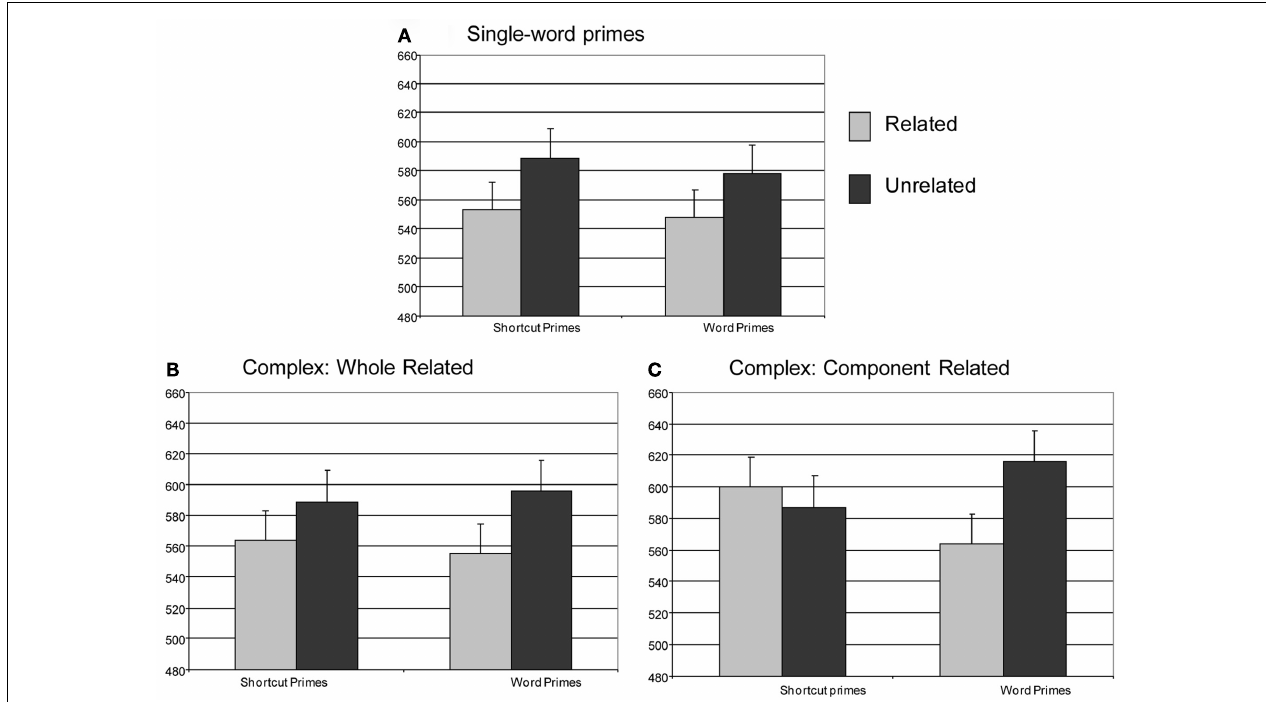
FIGURE 2 | Results of Experiment 2: mean reaction times (ms) as a function of Relatedness and PrimeType for single-word primes (A), whole-related complex primes (B) and component-related complex primes (C). Error bars show the